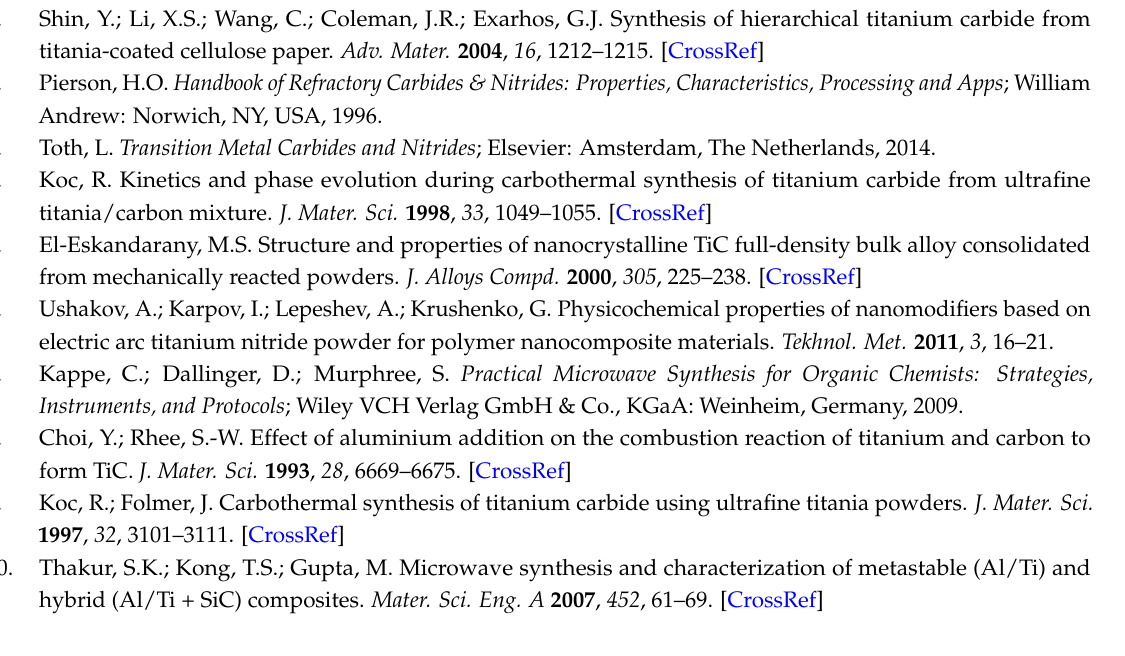
Lattice Constant of TiC (Å)TiO 2 C TiC